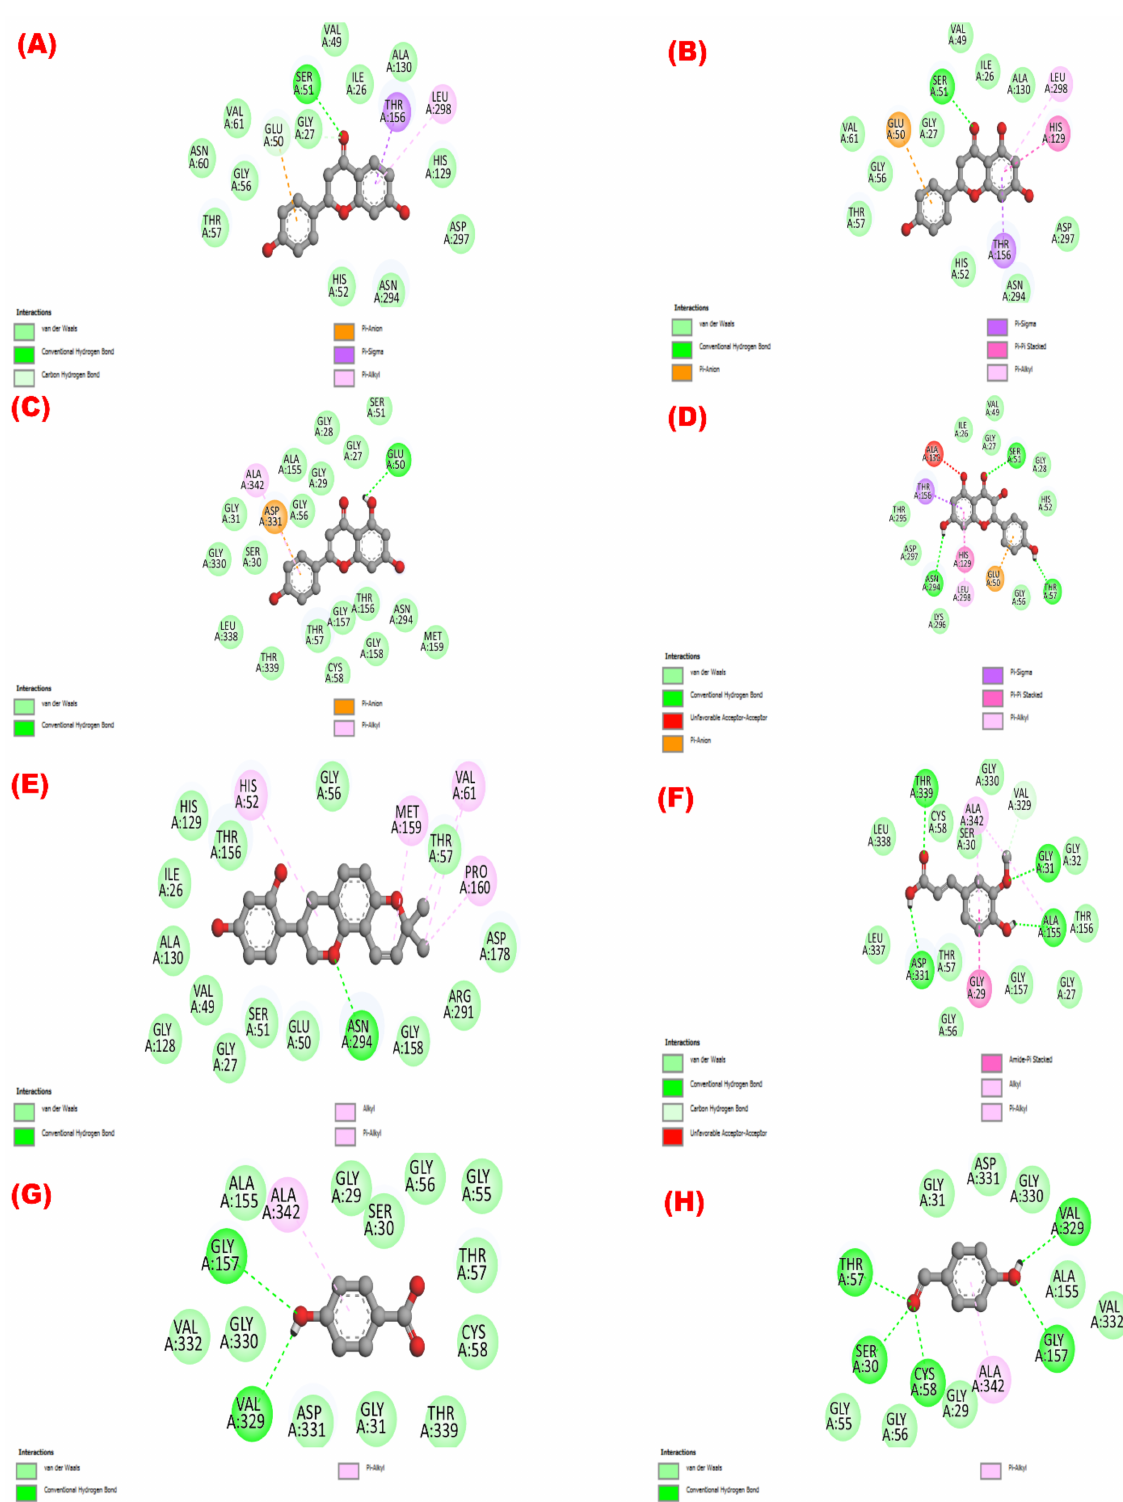
Figure 2. The isolated phytochemicals’ potential as antioxidants showing their 2D molecular interac- tions with the glutathione reductase enzyme (PDB ID: 3GRS). The 2D visual images of the molecular docking of the molecules ( 1 to 8 ) liquiritigenin, naringenin, apigenin, kaempferol, glabridin, ferulic acid, 4-hydroxybenzoic acid, and 4-hydroxybenzaldehyde are shown in ( A – H ),